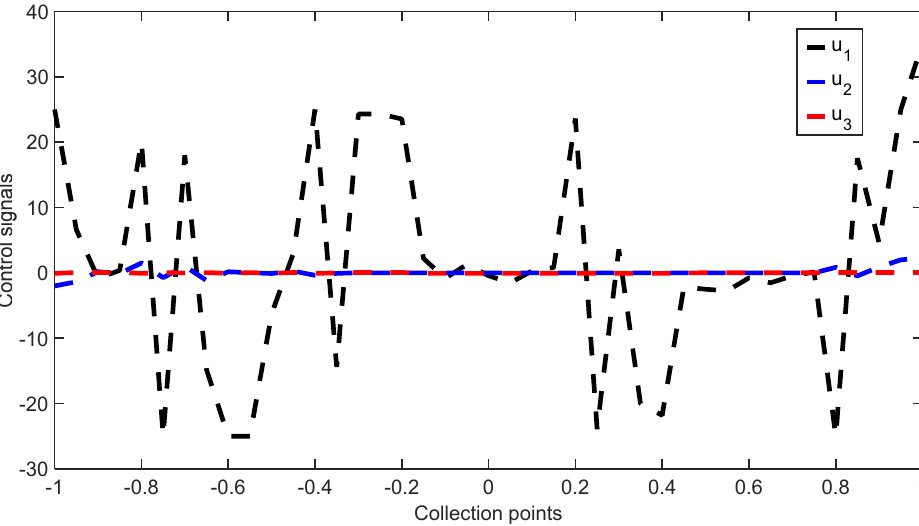
Figure 7. The LGR collection points of control signals.